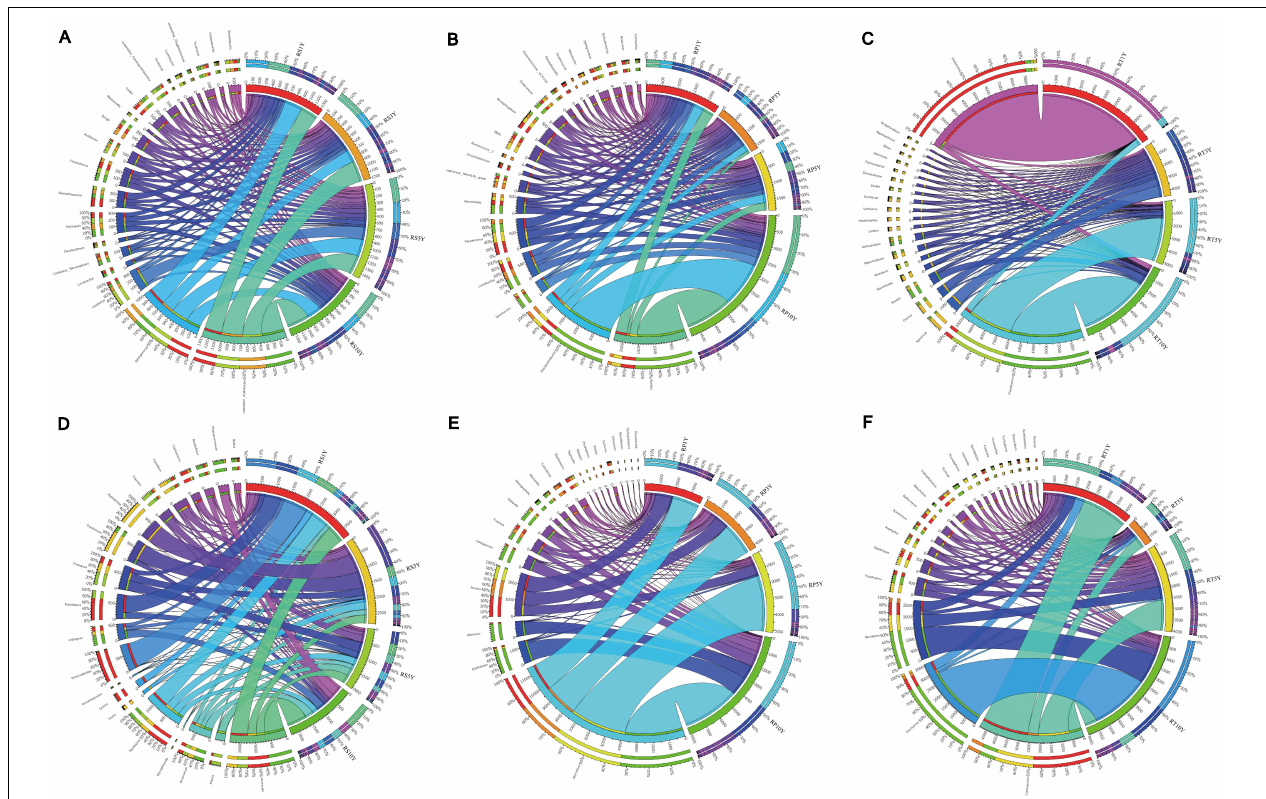
FIGURE 2 | Distribution of dominant (top 20) genera in four different samples in three root-associated compartments. [ (A–C) represent the bacterial community in rhizosphere, rhizoplane, and root, respectively; (D–F) represented the fungal community in rhizosphere, rhizoplane, and root, respectively]. The thickness of each ribbon represents the abundance of each taxon. The relative tick above the outer segment stands for the relative abundance of each taxon. The data were visualized using Circos (Version 0.69,